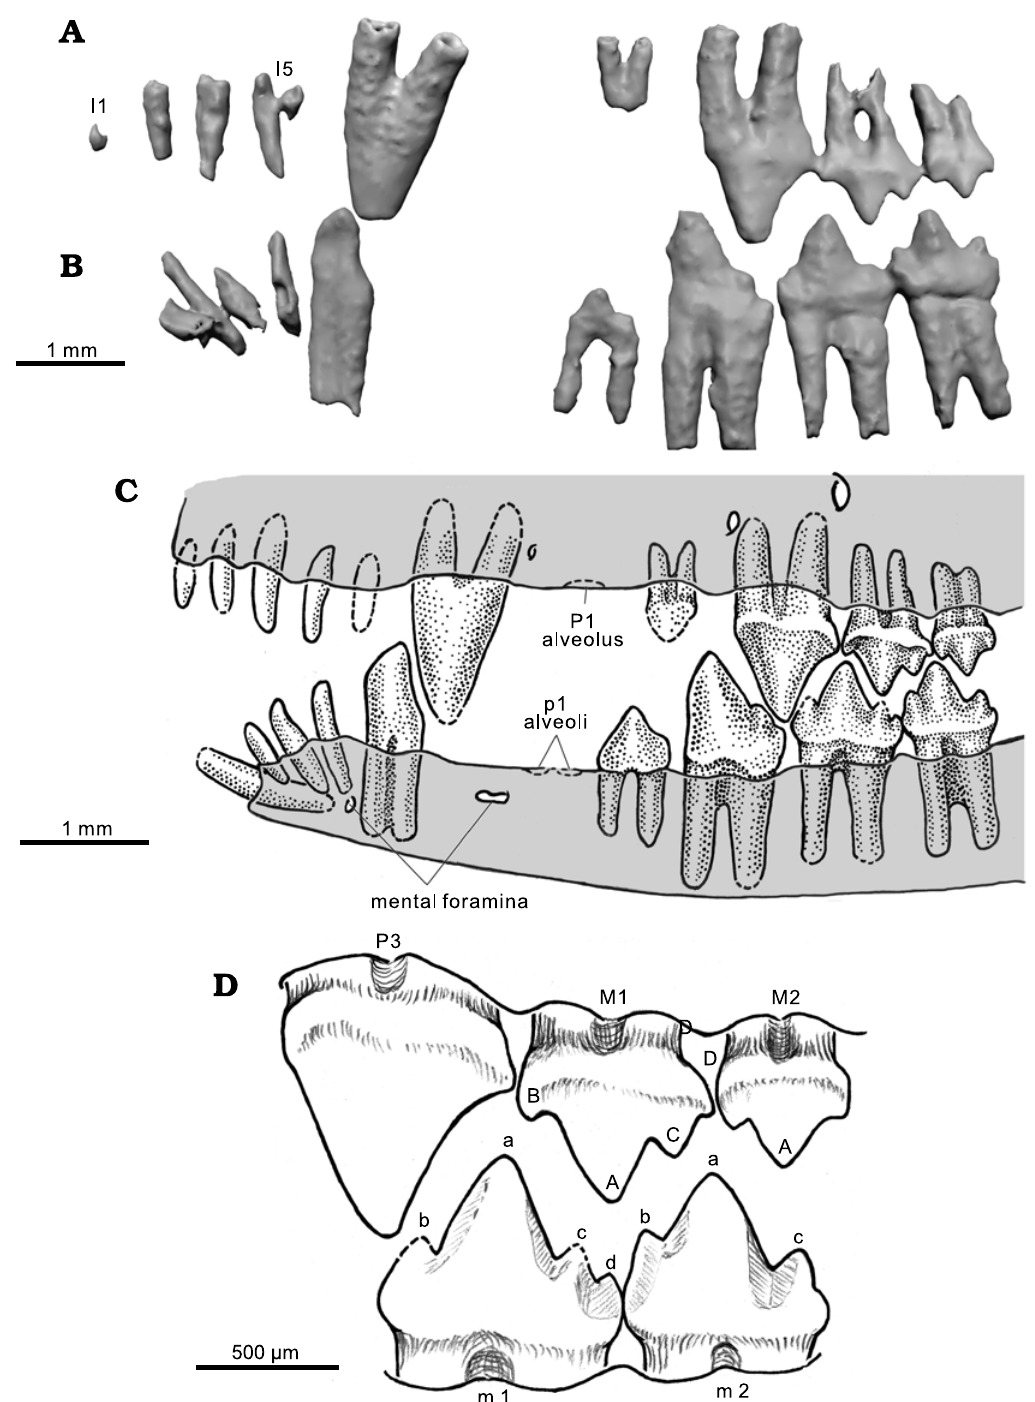
Fig. 6. Composite reconstruction of full dentition of Hadrocodium wui Luo, Crompton, and Sun, 2001 (holotype, IVPP 8275) from the Lower Lufeng Formation, Lower Jurassic of Yunnan, China. A . Left upper teeth (as preserved) in labial view (CT visualization). B . Lower teeth (as preserved) in lingual view. C . Composite reconstruction of upper and lower teeth (left labial view). D . Occlusal relationship of cusps between lower m1–m2 and upper P3–M1– M2 (revised from Luo et al 2001: fig. 1; cusp designation following Crompton and Jenkins 1968 and Crompton could not rule out that this difference is caused by preserva- tion differences of the left P3 versus the right P3. The upper M1 is better preserved on the right side than left and right P3s show an asymmetrical variation on two the left. This tooth bears three main cusps: the primary cusp sides: the left P3 has a weakly developed cusp on the poste- A in the middle, a lower but pointed cusp B on the mesial rior crest, which is entirely absent on the right P3 (Fig. 7). We